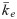
Ribosome dynamics under experimentally reported initiation and elongation rates.A) Simulated mean number of codons between ribosomes for the β-actin gene as function of initiation and elongation constants. In the plot, previous literature initiation and elongation values are highlighted by the squares [6–10], and values estimated in this study are denoted by asterisks. B) Simulated number of collisions per ribosome as a function of initiation and elongation constants. C) Top panel, kymograph showing the ribosomal dynamics for SunTag-24X-Kif18b using experimentally determined parameters ki = 1/100 sec−1 and k¯e = 3.1 aa/sec [10]. Center panel, kymograph showing the ribosomal dynamics for FLAG-10X-KDM5B using experimentally determined parameters ki = 1/30 sec−1 and k¯e = 10 aa/sec [6]. Bottom panel, kymograph showing the ribosomal dynamics for SunTag-56X-Ki67 using experimentally determined parameters ki = 1/13 sec−1 and k¯e = 13.2 aa/sec [9]. White lines in kymographs represent single ribosome positions, and green spots represent ribosome collisions.